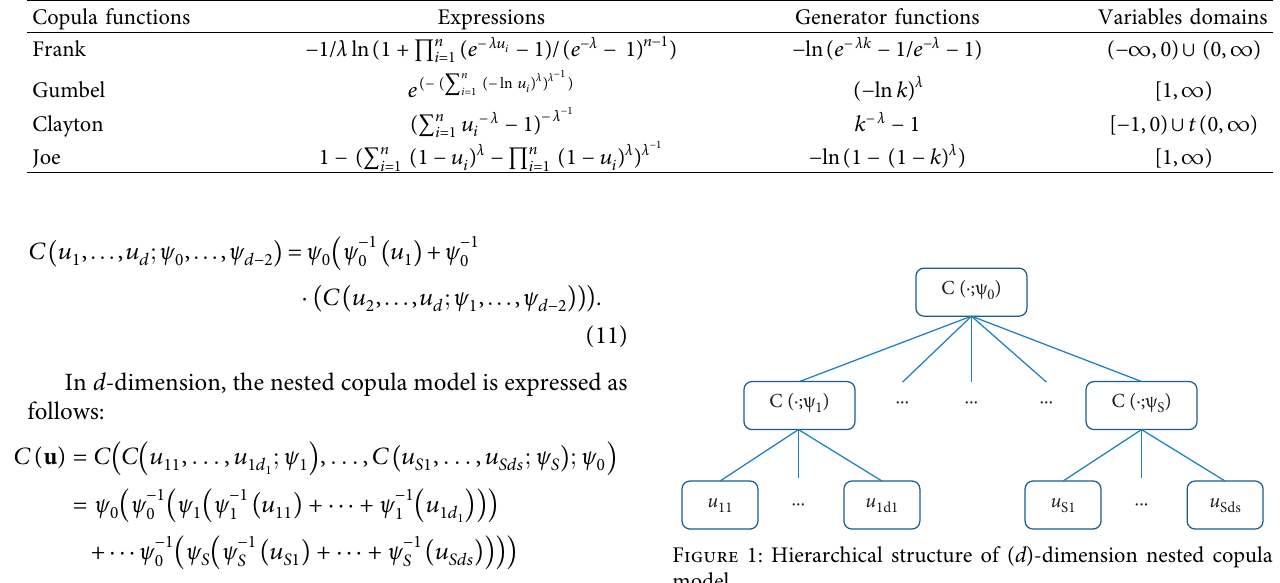
Table 1: Common Archimedean copula functions.